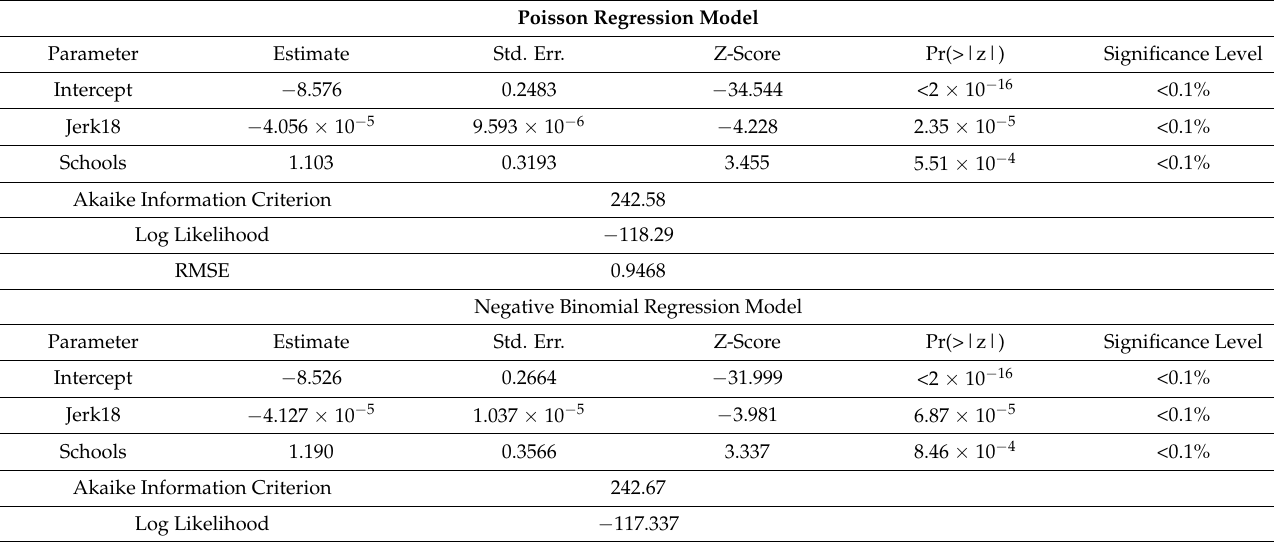
Table 3. Summary of regression models for intersection